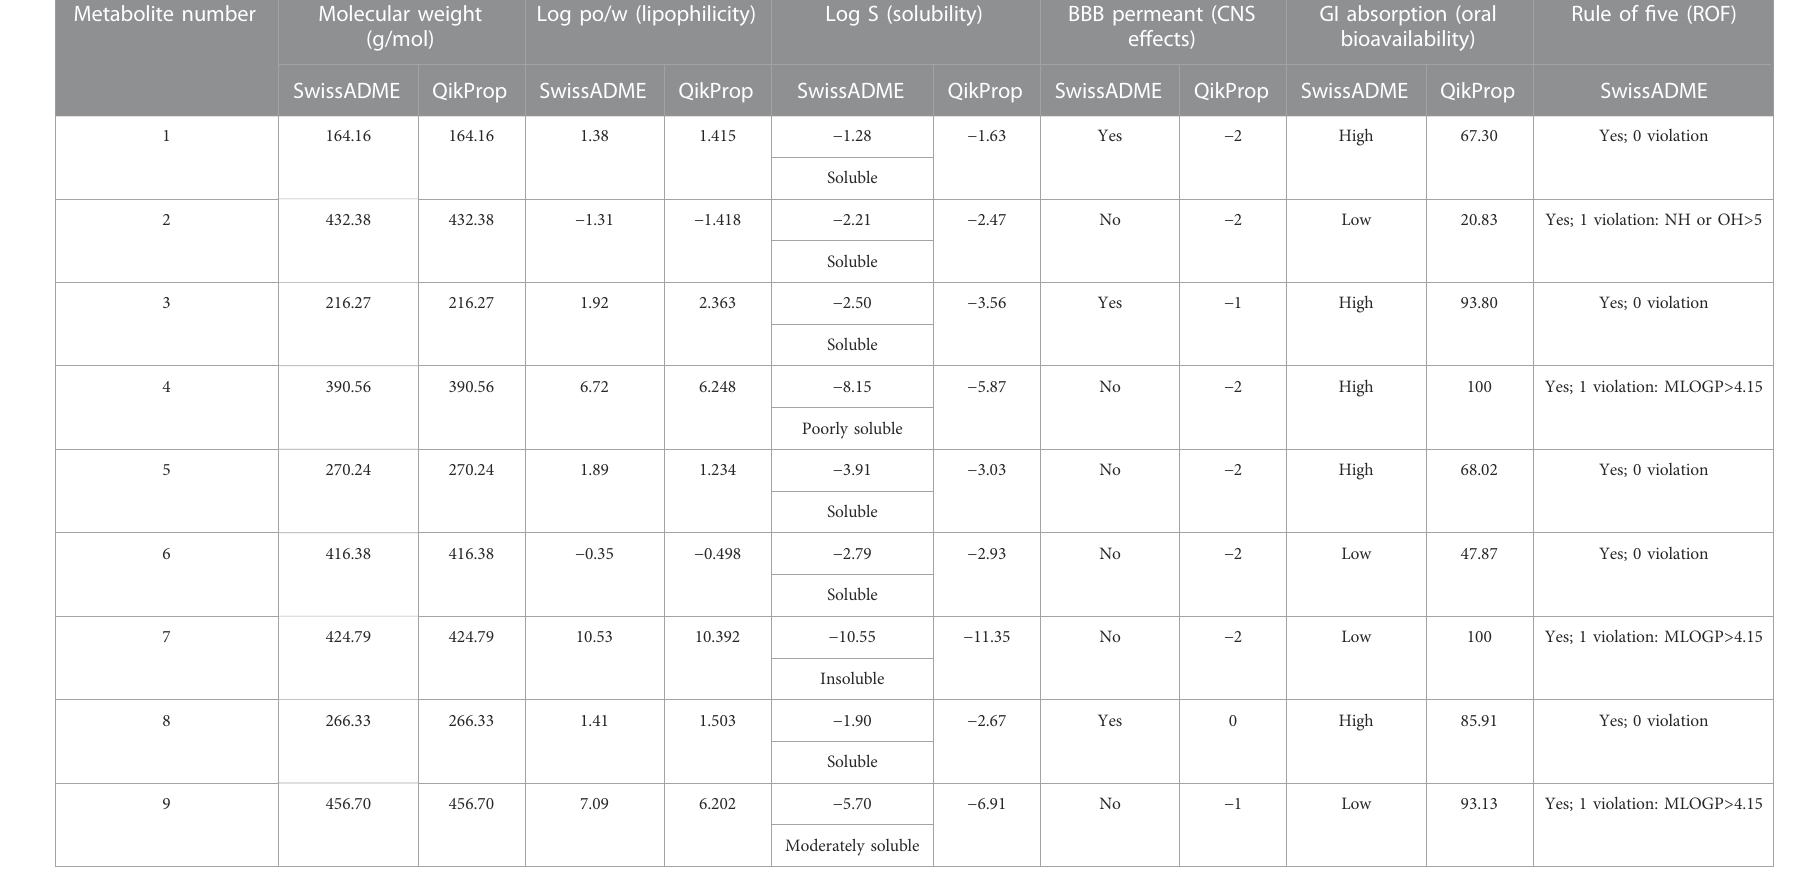
TABLE 3 Predicted pharmacokinetic parameters for identi fi ed metabolites derived from Lycium shawii L. methanolic extract using the SwissADME and QikProp tools. Metabolite